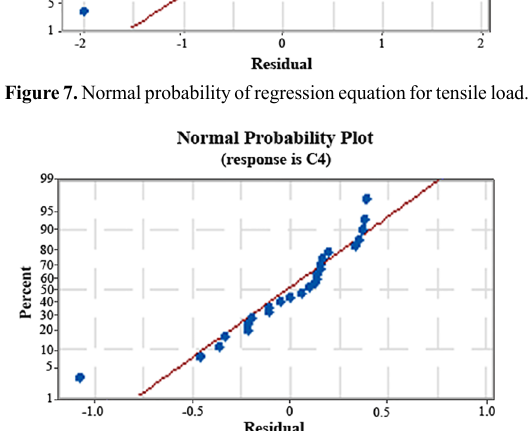
Figure 8. Normal probability of regression equation for flexural